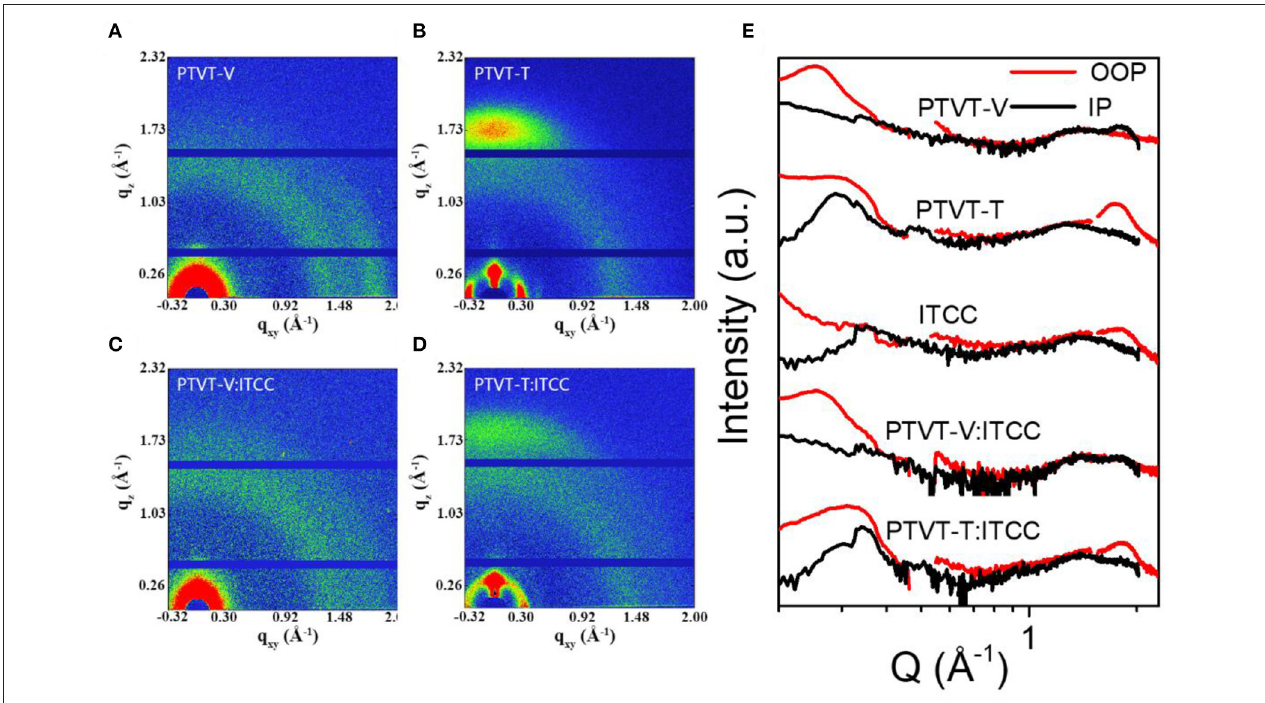
FIGURE 4 | The 2D scattering patterns of (A) PTVT-V, (B) PTVT-T, (C) PTVT-V:ITCC and (D) PTVT-T:ITCC. (E) The corresponding OOP and IP GIWAXS profiles of both neat and blend films.